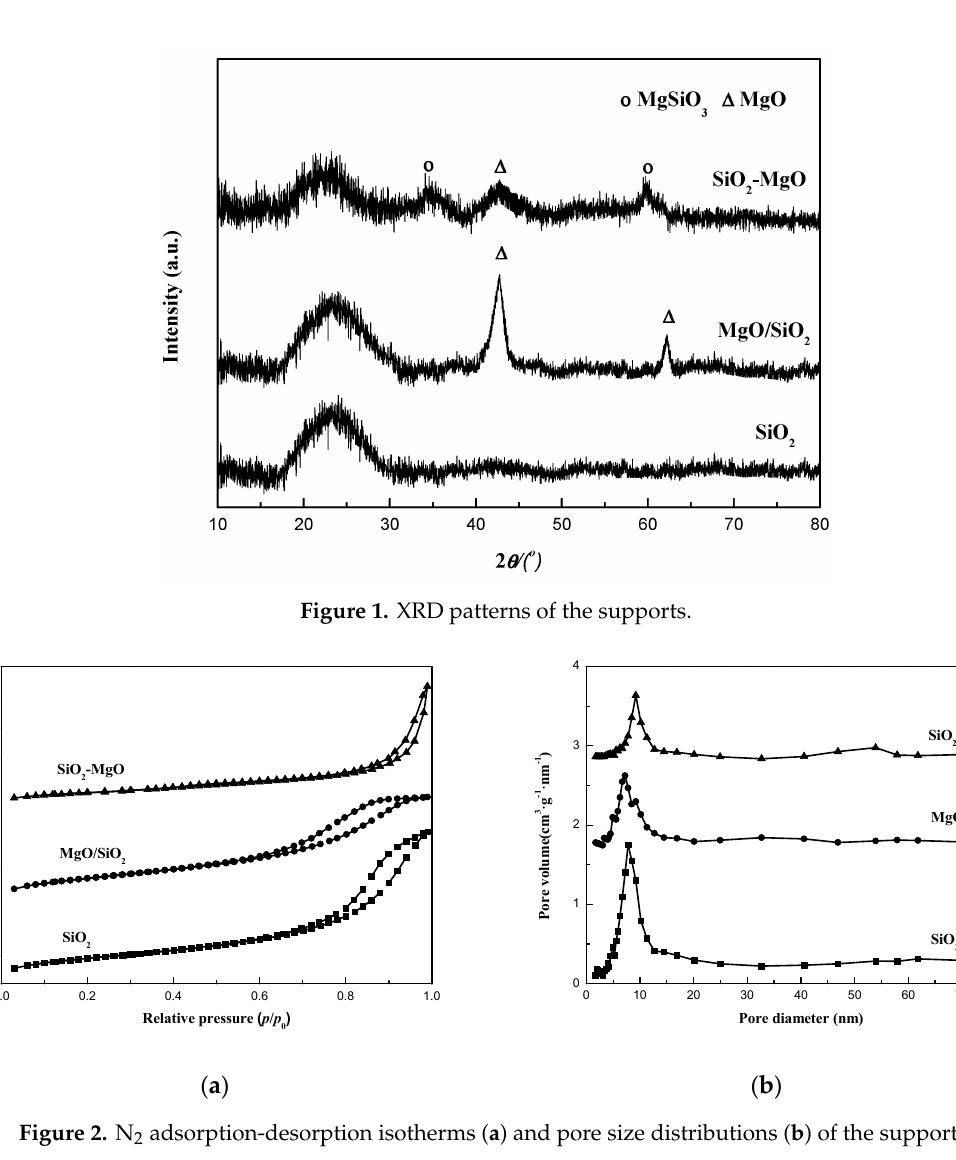
Figure 2. N 2 adsorption-desorption isotherms ( a ) and pore size distributions ( b ) of the supports.